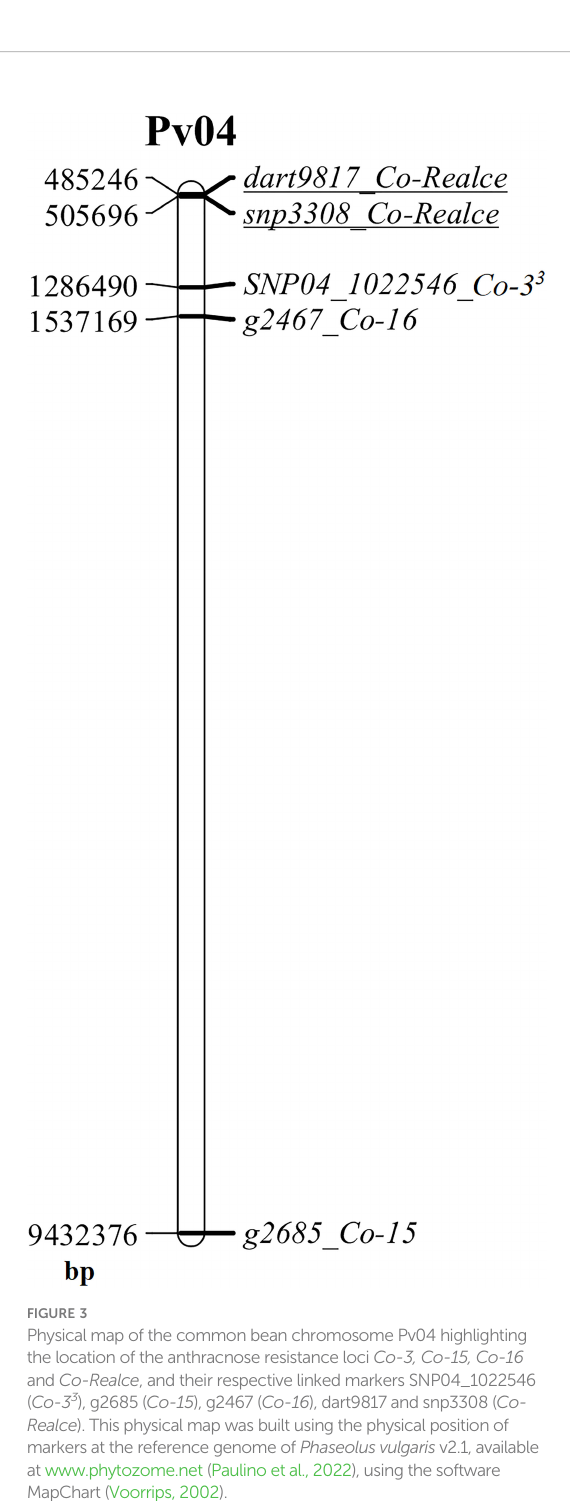
(Supplementary Table 2), in carioca seeded advanced lines. This breeding strategy aims to broadening the genetic resistance to anthracnose in the Brazilian common bean elite germplasm.